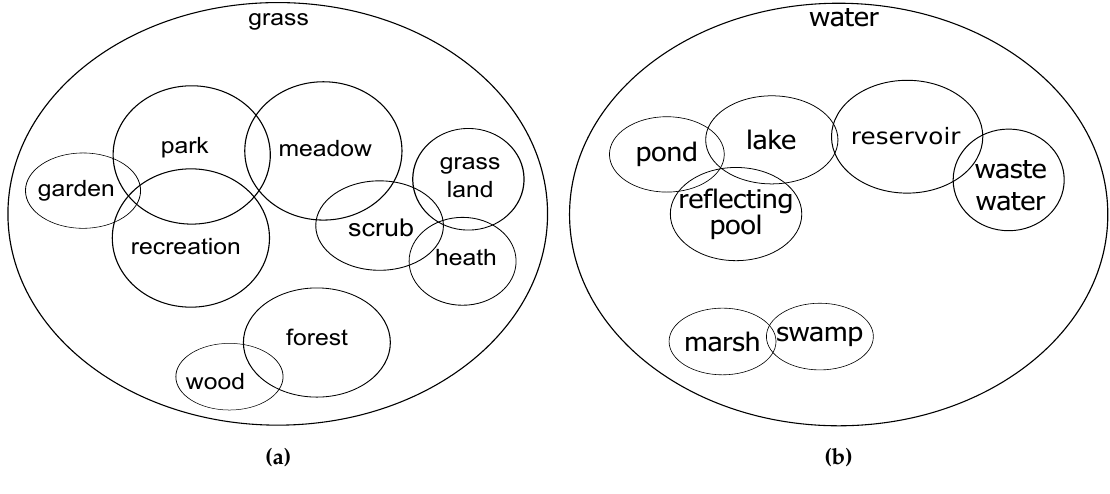
Figure 2. Conceptual overlapping classes due to the given descriptions in the OSM Wiki. Examples of ( a ) overlapping grass-related classes, ( b ) overlapping water-related